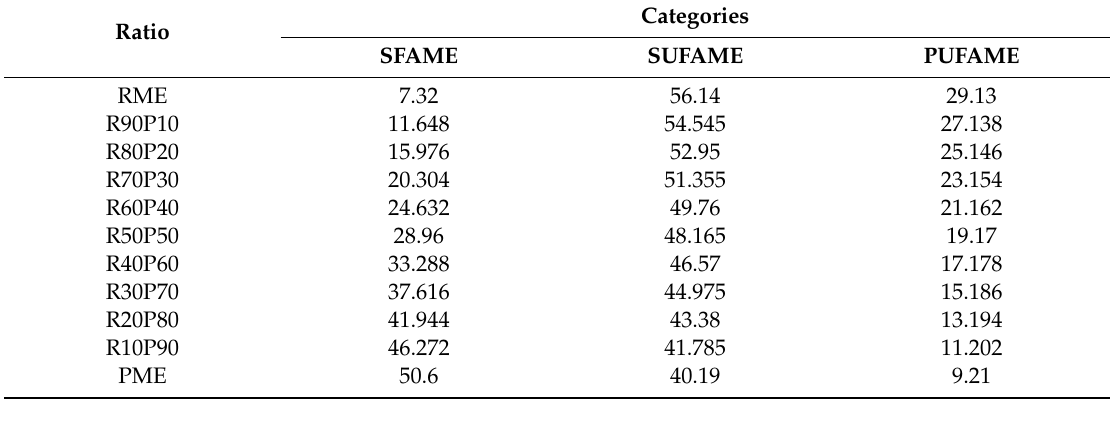
Table 4. Composition of fatty acid methyl esters of blended fuel.